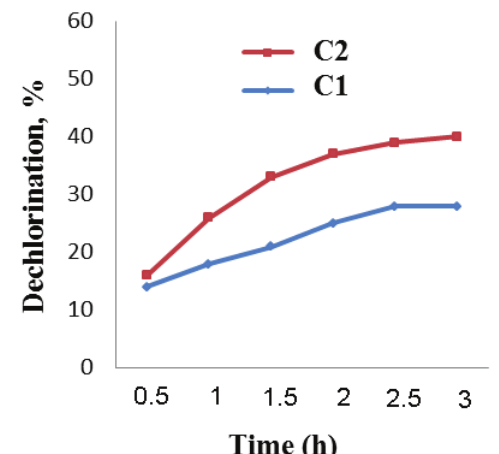
Fig. 7. catalytic dechlorination of MCB over C1 and C2 catalysts.